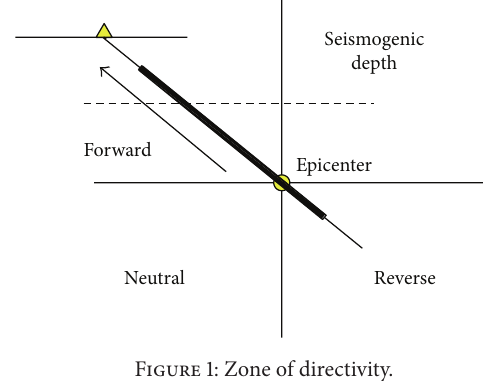
Figure 1: Zone of directivity.